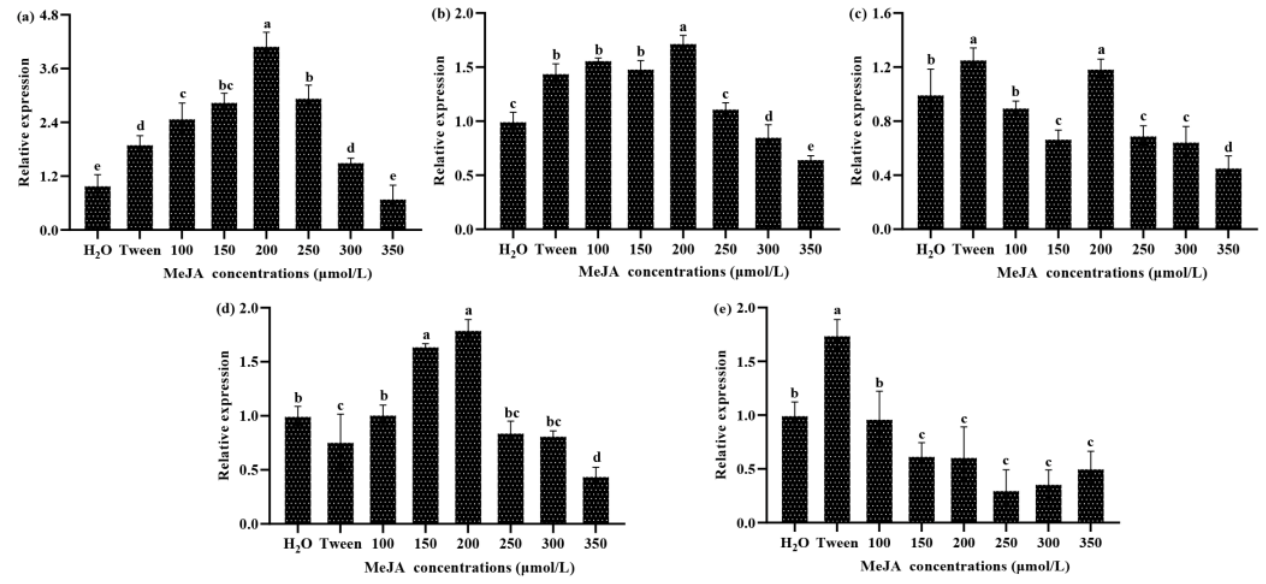
Figure 2. Changes in the transcript levels of five triterpenoid biosynthesis genes in response to MeJA concentrations in S. baumii . qRT-PCR assays were used to calculate the relative expression of the ( a ) HMGR , ( b ) IDI , ( c ) SQS , ( d ) SE , and ( e ) LS genes. The mean difference being significant at the 0.05 level, p < 0.05.